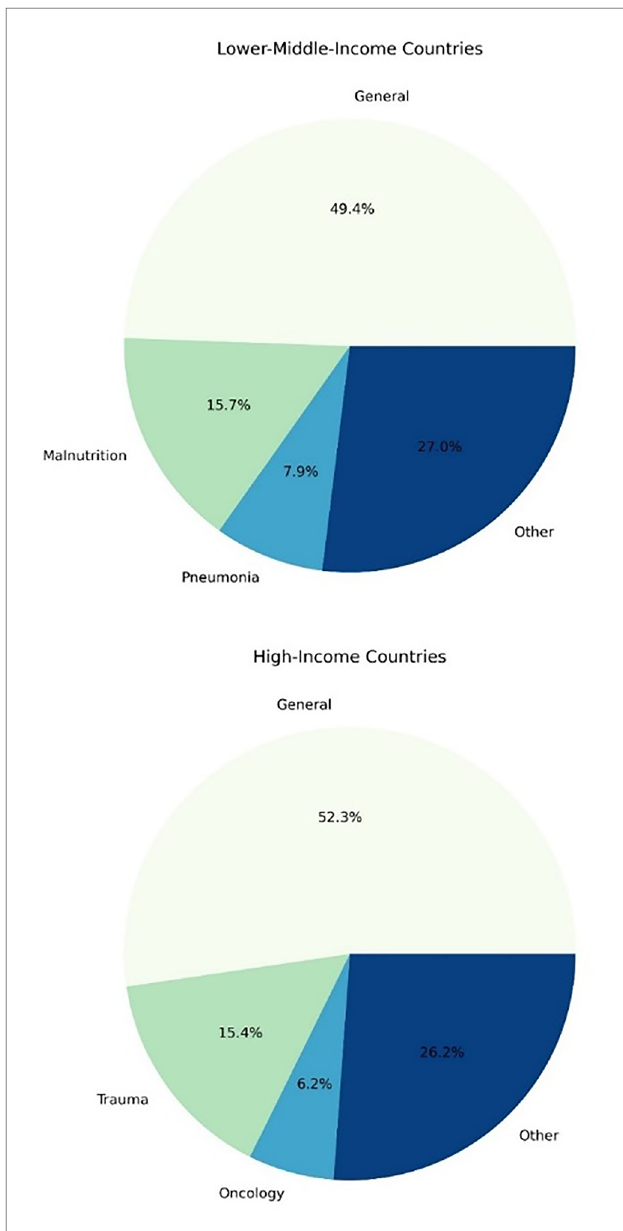
FIGURE 3 The frequency of pathological categories evaluated in studies reporting risk factors for mortality in hospitalised